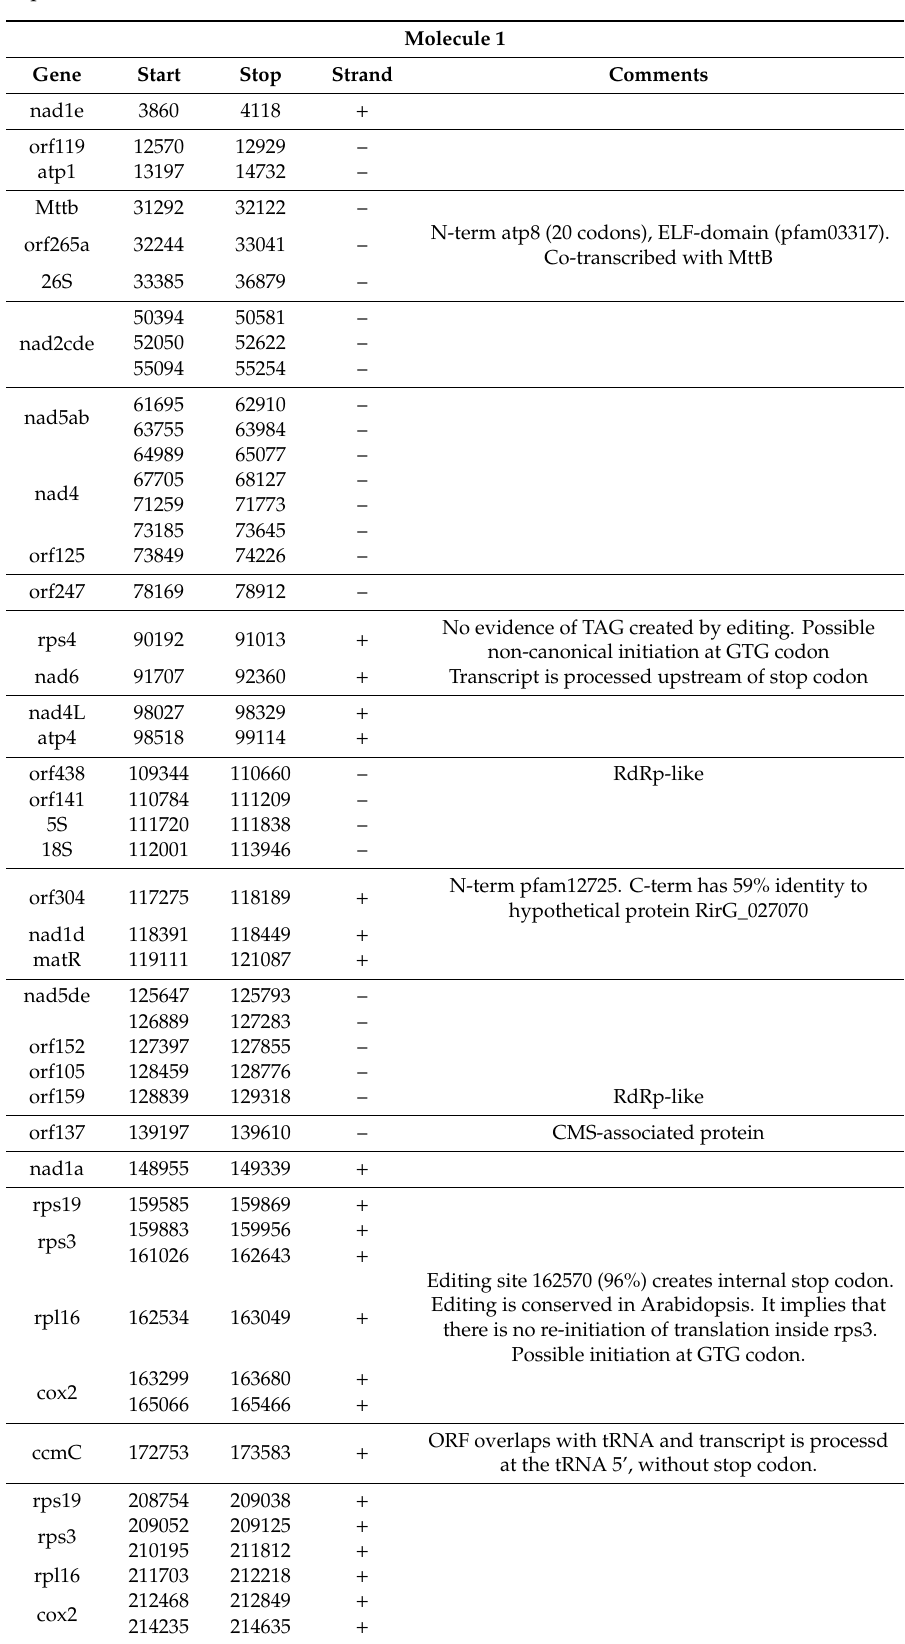
Table 1. List of transcribed protein-encoding genes and orfs. Genes are clustered according to transcription